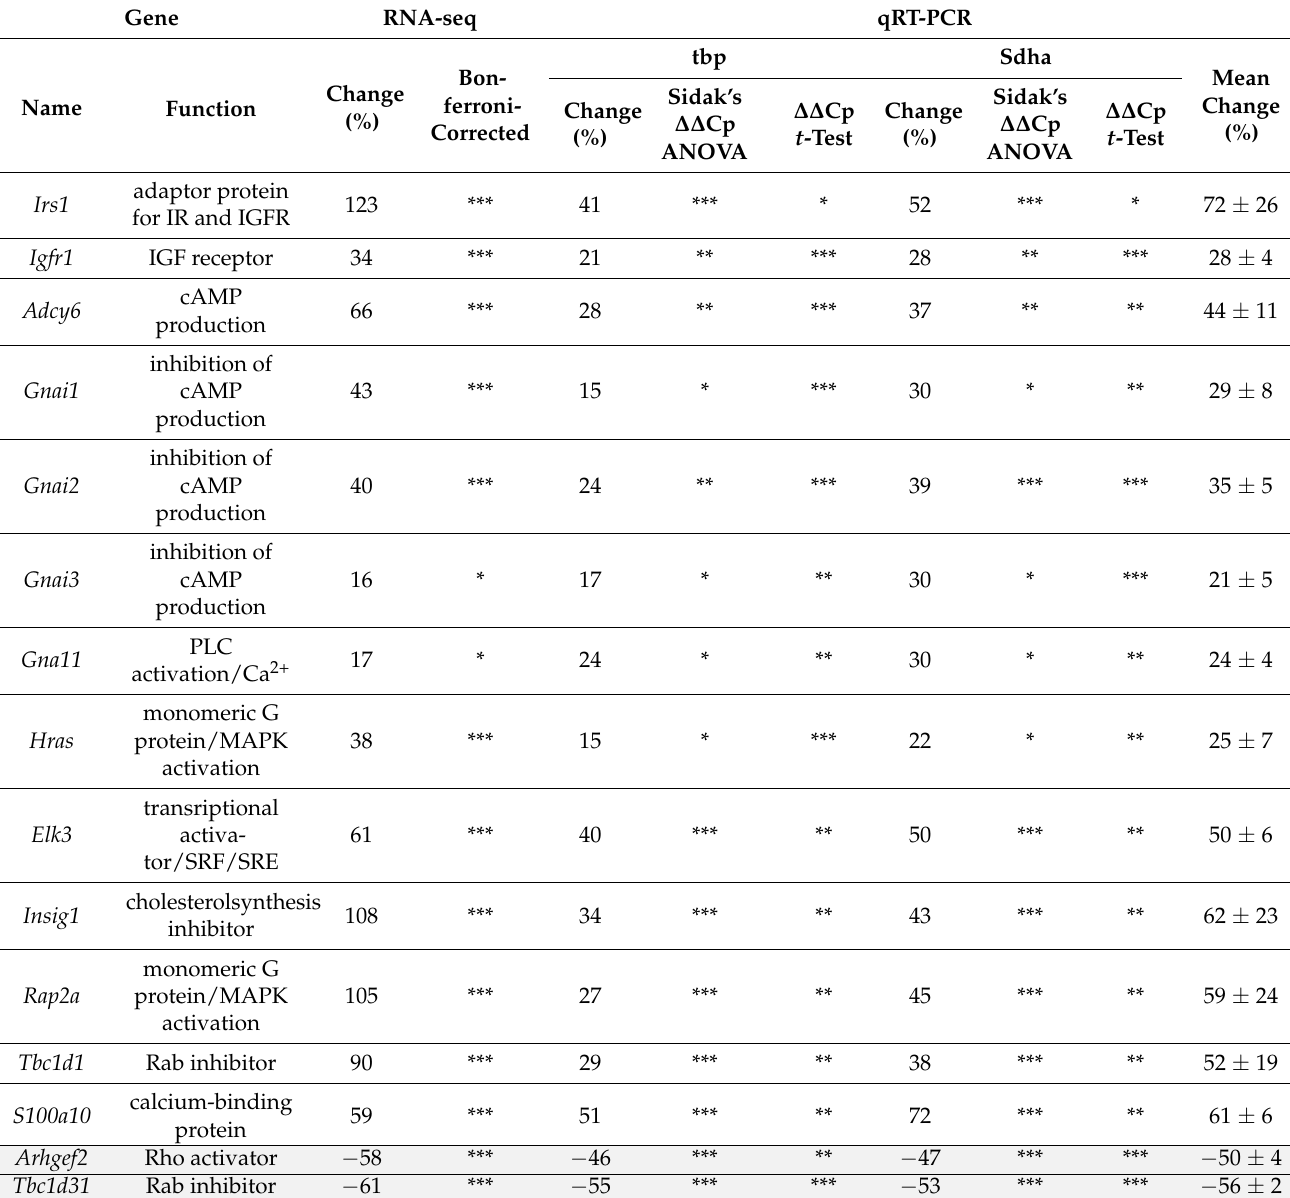
Table 1. mHypoA-2/10 cells were stimulated according to protocol 1 illustrated in Section 2.5, and RNA levels were determined by RNA-seq or qRT-PCR with Sdha or Tbp as a reference gene. For the RNA-seq data, differences were calculated on the basis of Bonferroni-corrected p -values. For the qRT-PCR data, ∆∆ Cp using Sdha or Tbp was calculated, and significant differences were determined using two-way ANOVA and Sidak’s post-test or two-sample t-tests. Mean change indicates alterations based on all three data sets. White background indicates gene induction, grey background gene